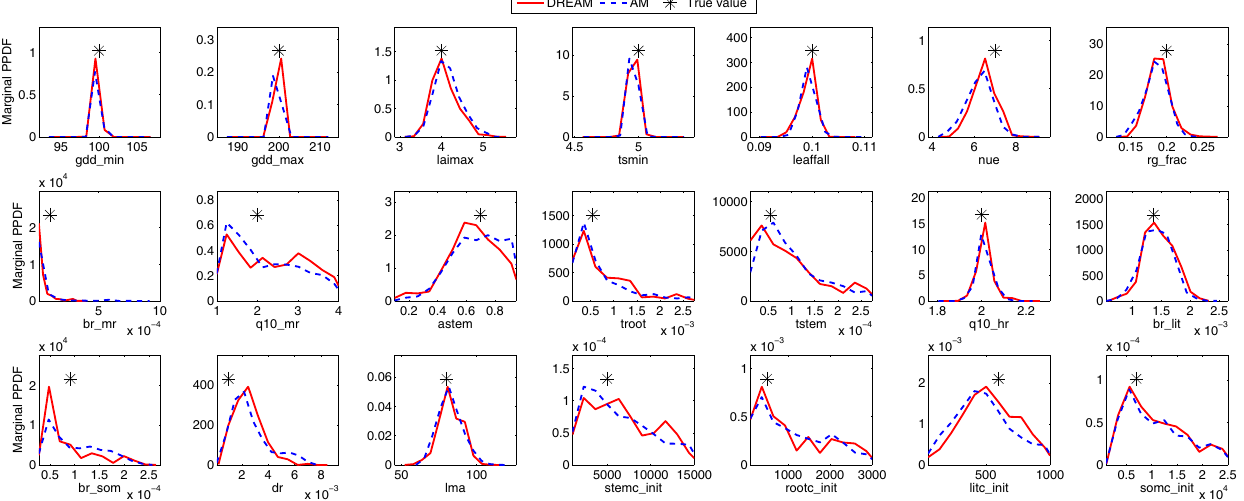
Figure 1. Estimated marginal posterior probability density functions (PPDFs) of the 21 parameters using the AM and DREAM algorithms, along with the true parameter values to generate the pseudo-data in the synthetic